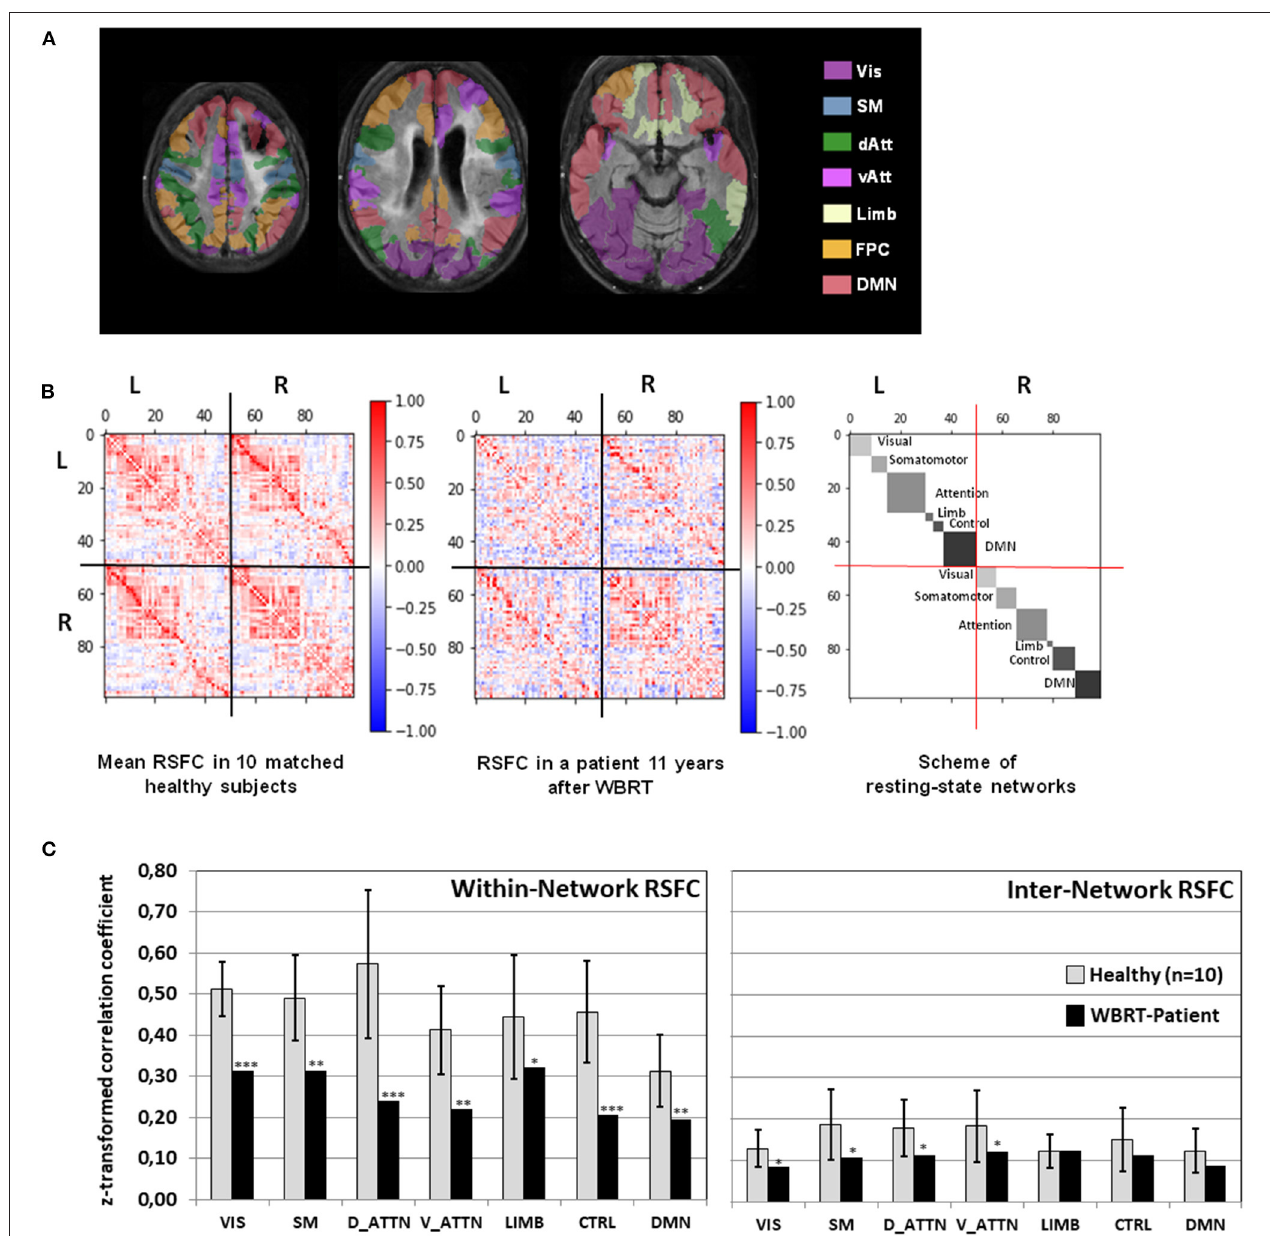
FIGURE 3 | (A) Overlay of the patient’s FLAIR images registered to the MNI-152 space with the color-coded cortical areas belonging to 7 resting-state networks. (B) Mean resting-state functional connectivity in 10 healthy subjects and in the patient depicted together with the scheme of resting-state networks. (C) Within-network and inter-network resting state connectivity (RSFC, mean z -normalized Pearson correlation coefficient of positive-valued connections) for each of the seven resting-state networks in the whole brain radiotherapy (WBRT) patient compared to the healthy subjects. For the healthy subjects, means ± standard deviations are depicted. * p < 0.05, ** p < 0.01, *** p < 0.001, one-sample t -test. Vis, Visual Network; SM, Somato-Motor Network; dAtt, Dorsal Attention Network; vAtt, Ventral Attention Network; Limb, Limbic Network; FPC, Fronto-Parietal Control Network; DMN, Default Mode